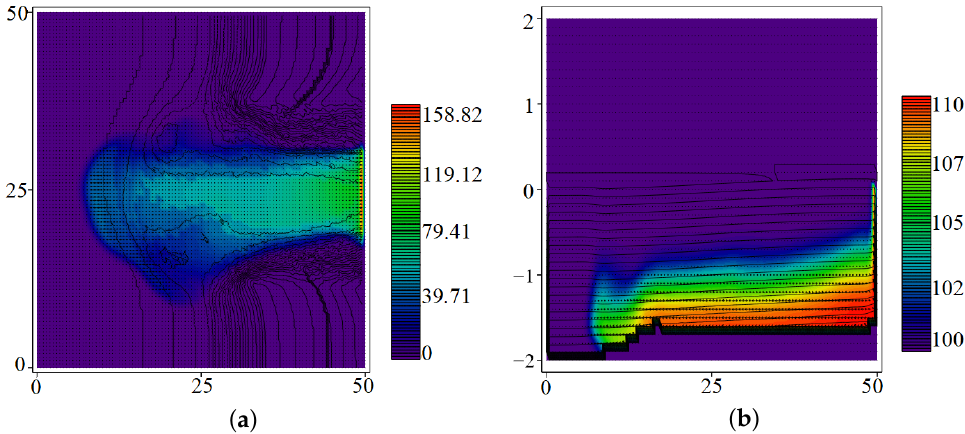
Figure 4. The movement of water and suspended matter in the mouth area after 1 min. ( a ) concentra- tion of suspended matter; ( b ) water